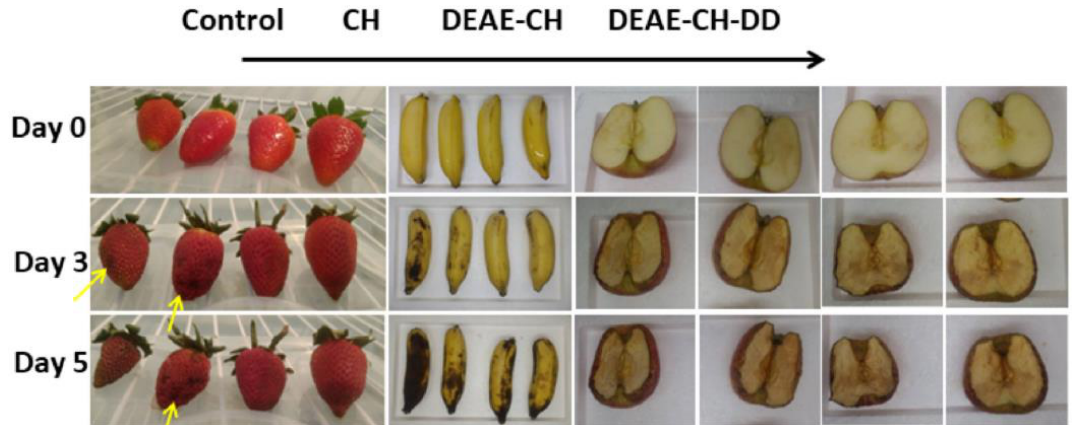
Figure 2. Visual decay of strawberries, bananas, and apples during storage time of 5 days. Each row shows the control on the left side, then the chitosan (CH)-, diethylaminoethyl chitosan derivative (DEAE-CH)-, and dodecyl grafted diethyla- minoethyl chitosan derivative (DEAE-CH-DD)-coated antimicrobial edible films towards the right, respectively. The yel- low arrows indicate signs of rot/spoilage. Reproduced with permission from [10]. (Copyright 2020 Elsevier).